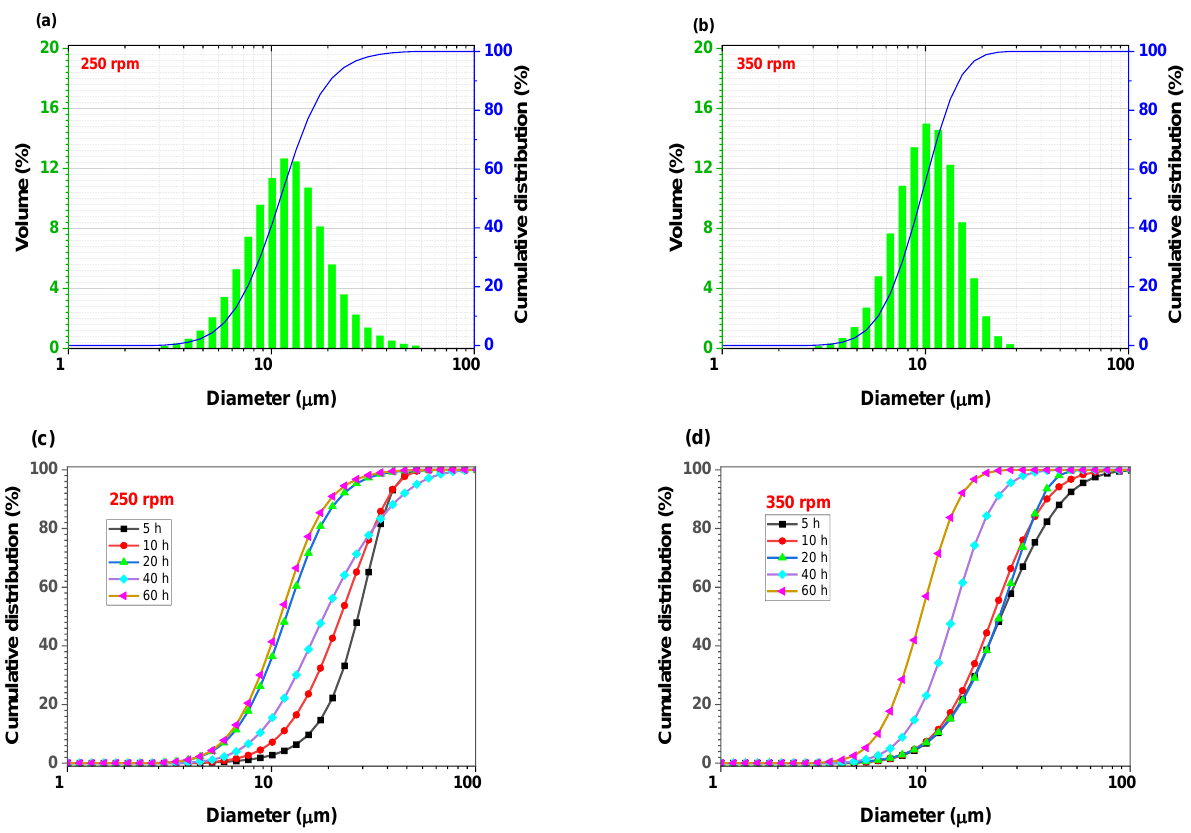
Figure 3. The typical particles size distribution of Al 82 Fe 14 Ni 4 alloy powders milled at ( a ) 250 rpm for 60 h and ( b ) 350 rpm for 60 h; cumulative distribution of the alloy powders milled at ( c ) 250 rpm and ( d ) 350 rpm. Table 2. Characteristics of particle size distributions for powders after MA,.